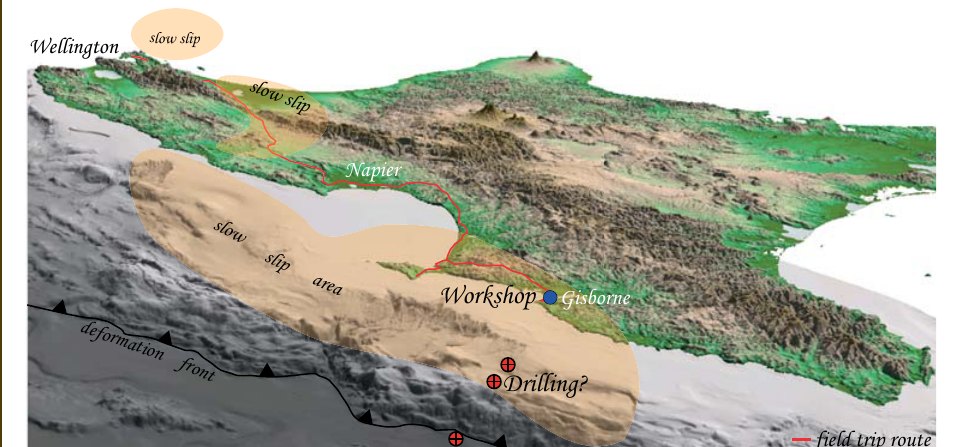
Figure 2. Oblique view of the Hikurangi subduction margin, including locations of slow slip (orange shaded areas), the location of the workshop and field trip route (orange solid line), and some of the proposed slow slip event drilling targets offshore